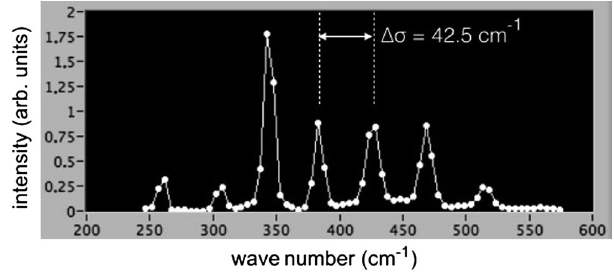
FIG. 5. Intensity of radiation vs time, at the macropulse timescale, for various undulator gaps.